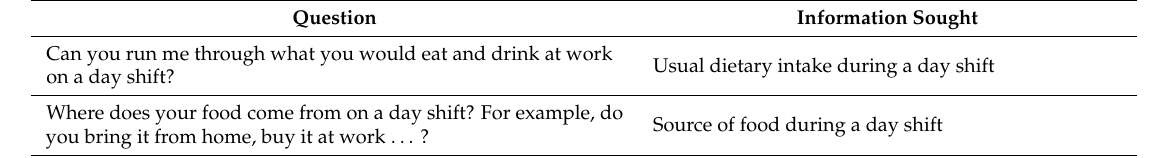
Table 1. Questions used to guide semi-structured focus group